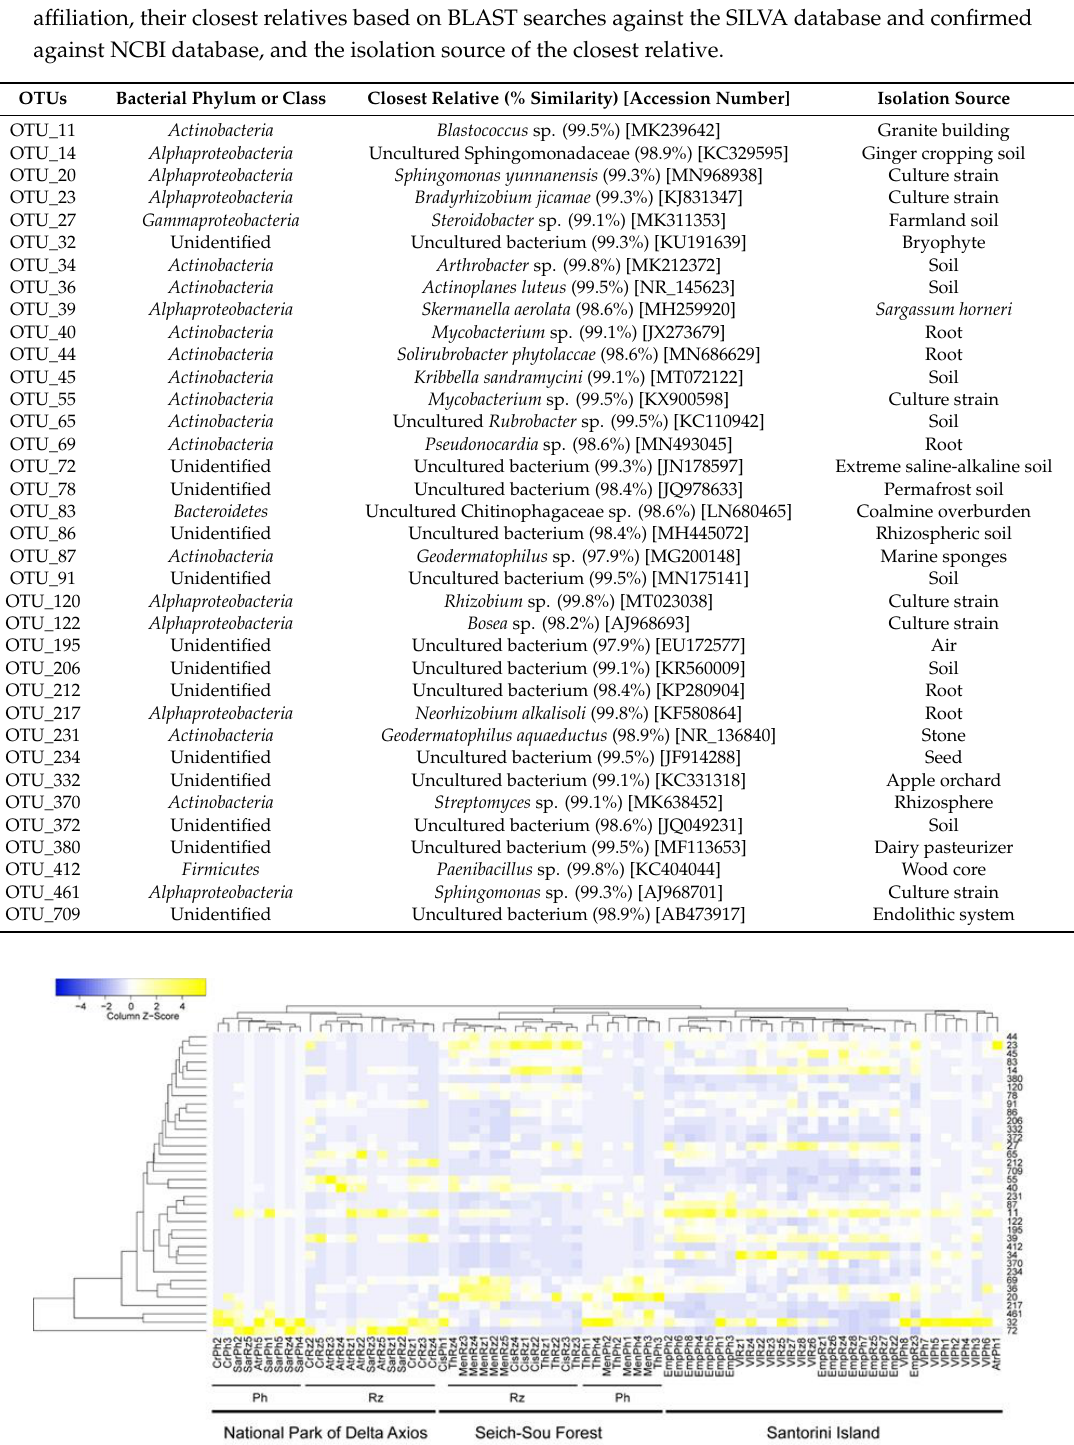
Figure 6. Heatmap of the number of reads of the 36 generalist OTUs as identified by Levins’ ( B ) index in all samples. The Average Linage clustering method with Euclidean distances was used to cluster the sampling